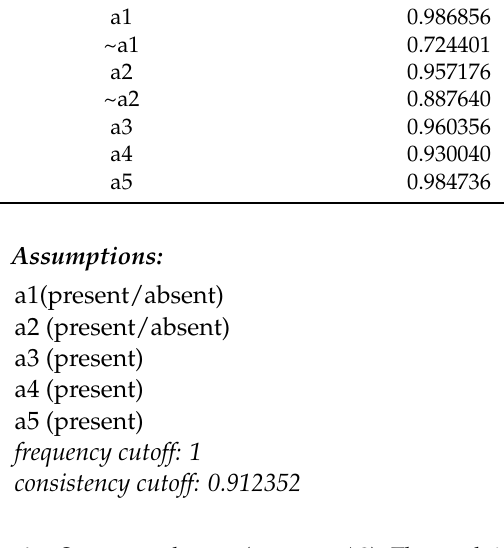
Table A8. Success pathways (outcome A2)- The mark * resembles